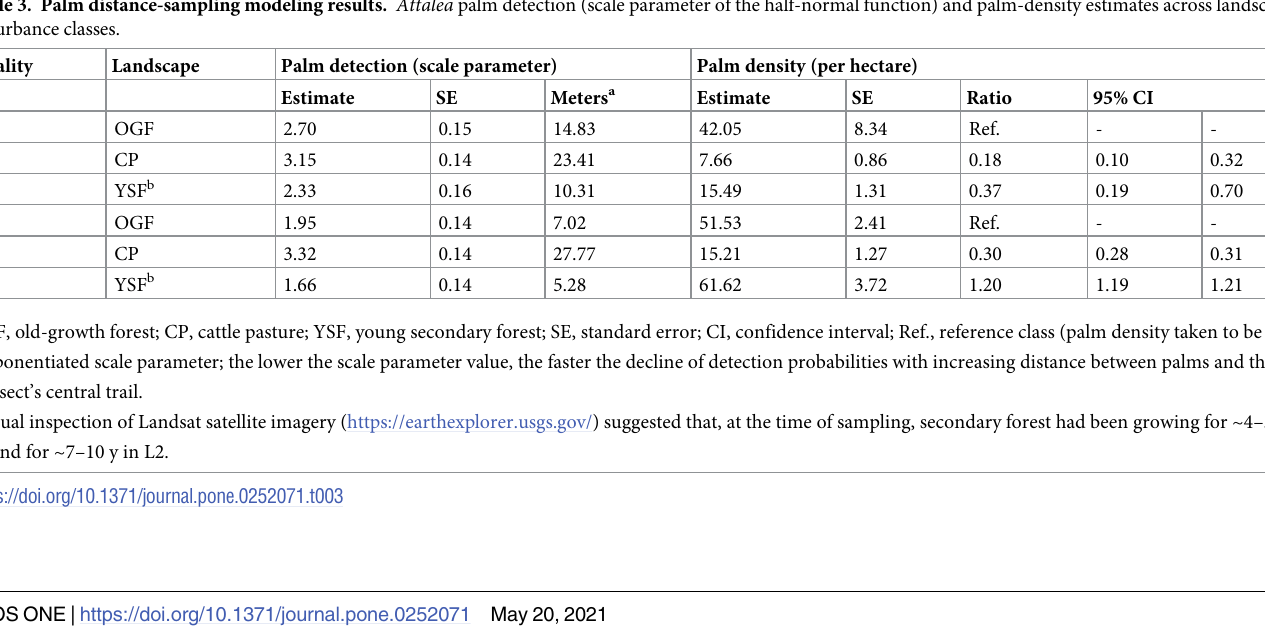
and ~14.3 times higher in recovering YSF (Fig 4A). Both the focal model and the simplified model fitted the data much better, as judged by large AIC differences ( > 40 units), than a “null” model estimating only intercepts. Density of Rhodnius spp. colonies in Attalea palm crowns. In line with the occupancy analyses above, our focal N -mixture model estimates strong positive effects of anthropogenic landscape disturbance on the mean density of Attalea palm-dwelling Rhodnius spp. The results are summarized in Table 5 and Fig 4B. This N -mixture model predicts higher mean bug